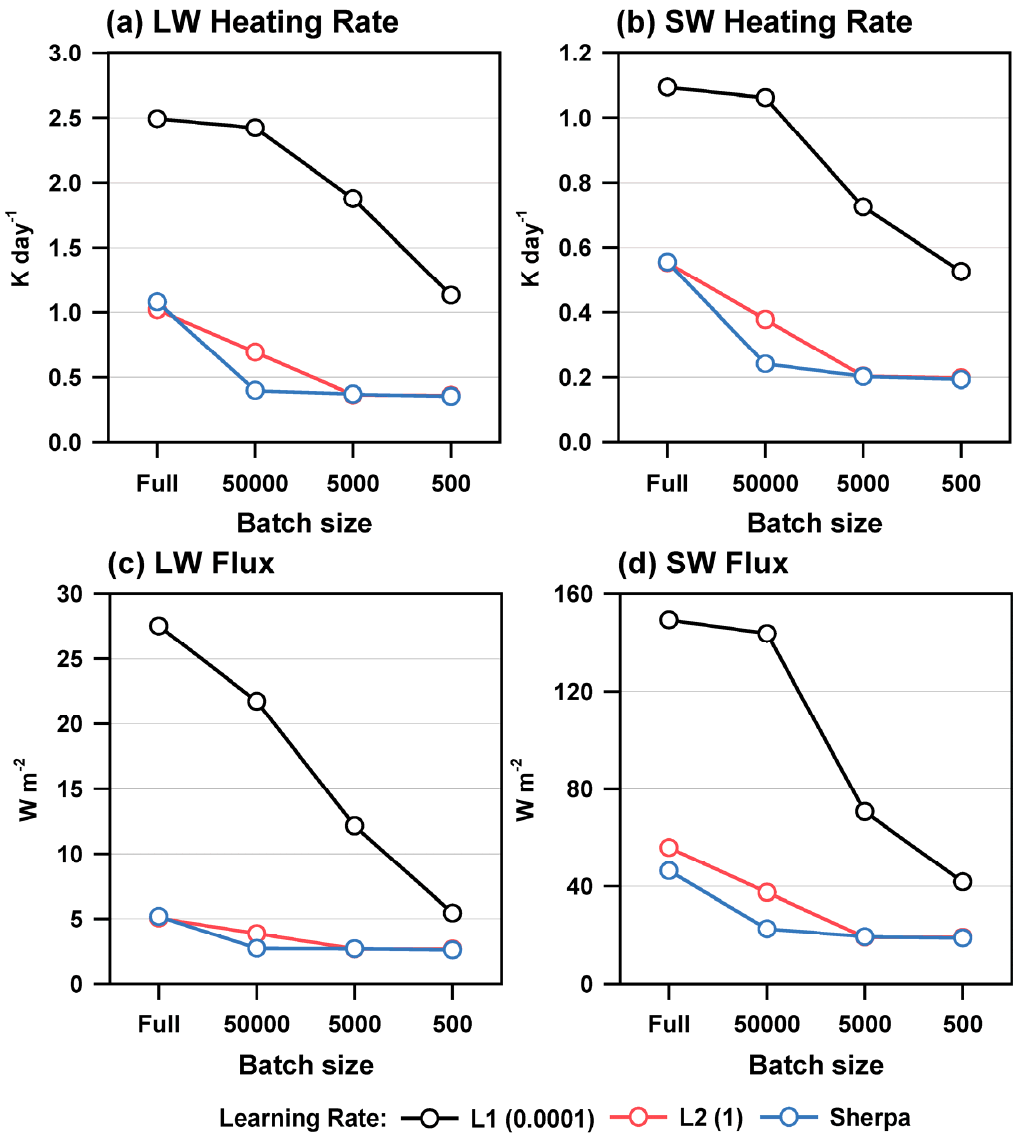
Figure 1. The root mean square errors (RMSEs) of ( a ) longwave (LW) heating rate, ( b ) shortwave (SW) heating rate, ( c ) LW flux, and ( d ) SW flux with different batch sizes and learning rates for validation sets including clear and cloud cases. Land and ocean, as well as clear and cloud, results were